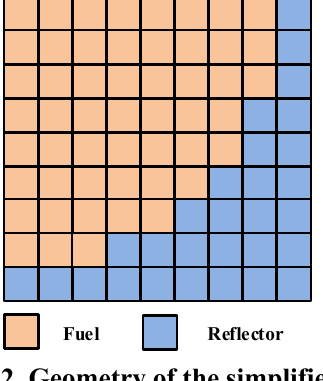
Figure 2. Geometry of the simplified core. Table I. The cross section configuration of the fuel and